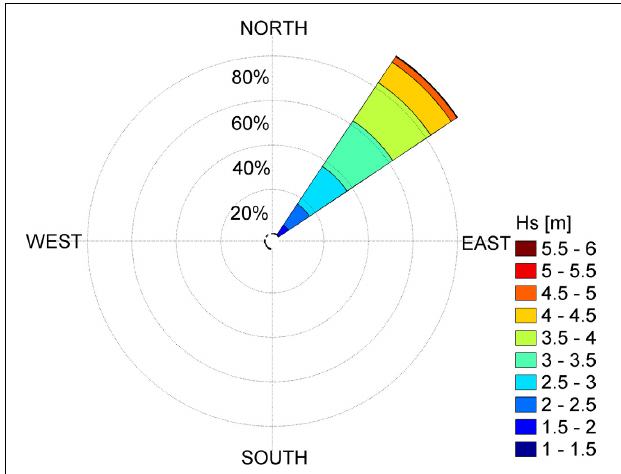
FIGURE 2 | Wave rose from the NOAA wave hindcast (WaveWatch III). 38 years (1979-2016) of 3-hourly significant wave height ( H S ) and wave direction ( D p ) from the closest grid point to Cartagena de Indias are used.